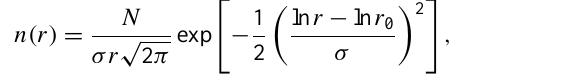
Table 1. Fit coefficients for estimation of BCFA optical properties at λ = 550nm and D f = 1 . 8. Relative RMSEs for all fitted points, equally weighted, are also given. The lower values marked “Rel. ∗ ” ignore the first two data points where n s ≤ 40, showing that this is where the majority of the relative error is contained. While the values of coefficient 1 (the linear term) in the fits of SSA and g are negligible at 550nm, they increase at longer wavelengths, while the values of coefficient 2 (the logarithmic term)